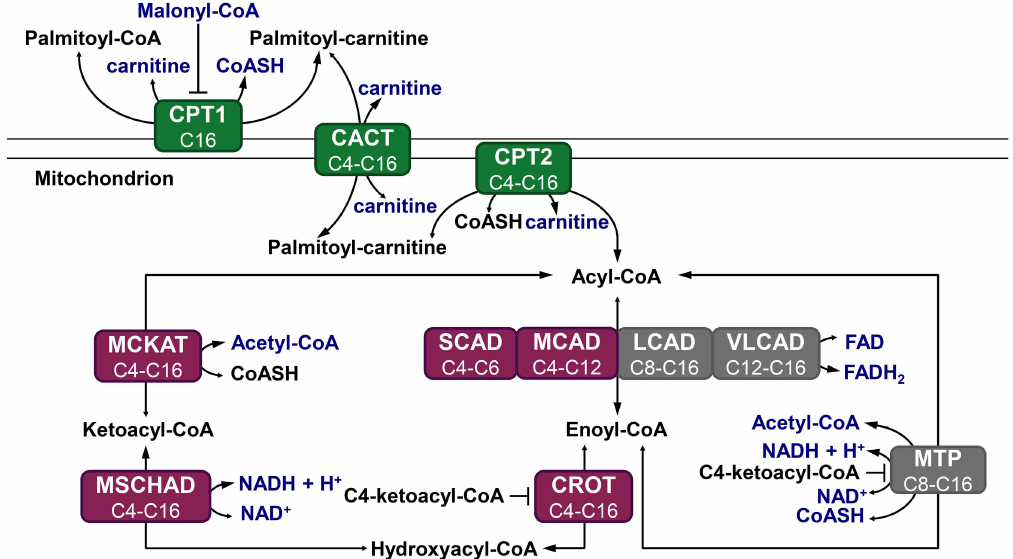
Fig 1. Schematicrepresentation of the modelled mFAO pathway in rat. Metabolitesin blue are fixed parameters, whileother metabolites are free variables.The sum of variableCoA esters and free CoA is a conserved moiety. Green: enzymes participating in the carnitinecycle; purple:enzymes participating in the short-chainbranch;grey: enzymes participating in the medium-andlong-chainbranch. All processes are reversibleandthe size of the arrowheads indicatesthe net directionof the flux. This modelis exactly the same as published before [8],without modifications.